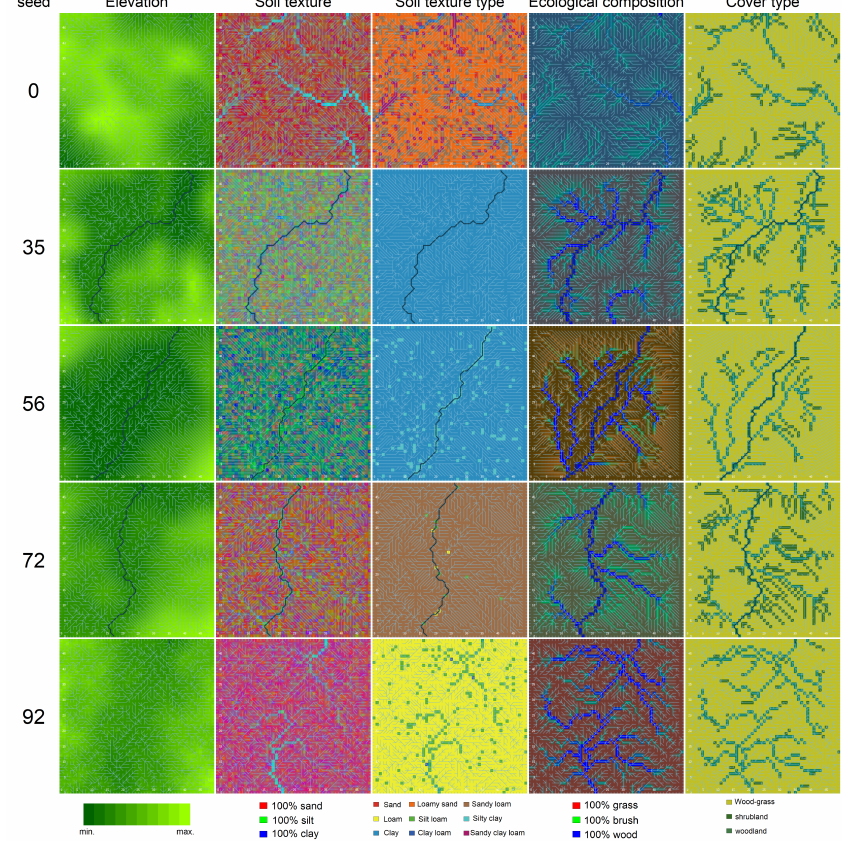
Figure 6. Terrains generated with the land model used in experiments 3, 4, and 5. Elevation, water flow, and soil texture composition and classification are displayed. Water flow is represented as blue links between land units, where thickness and color saturation are proportional to flowAccumulation at the origin. Soil texture types are derived using the USDA Textural Classification Chart [55]. Criteria for cover types are based on footnotes of Table 2.2 in